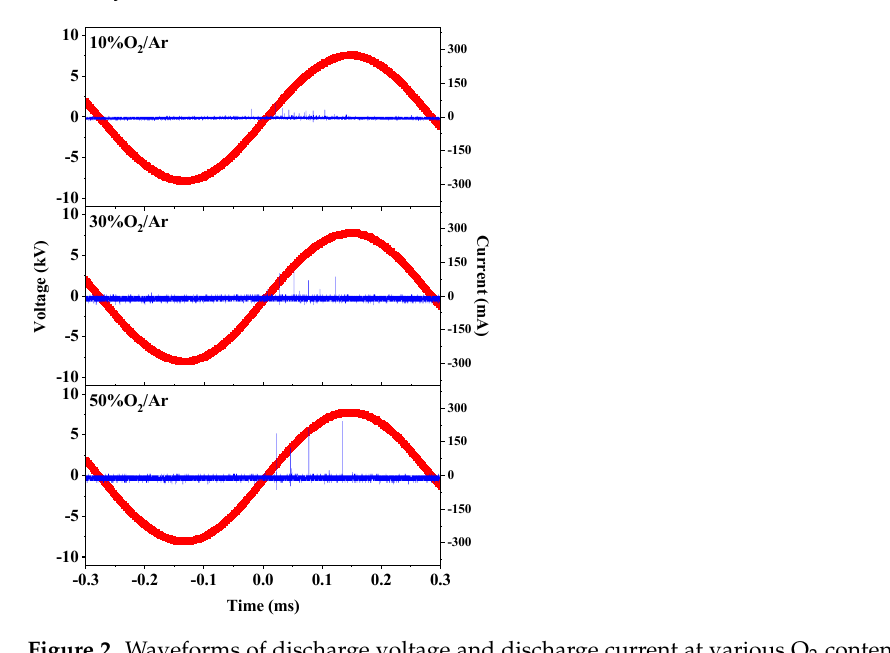
Figure 2. Waveforms of discharge voltage and discharge current at various O 2 contents in O 2 /Ar discharge gas.